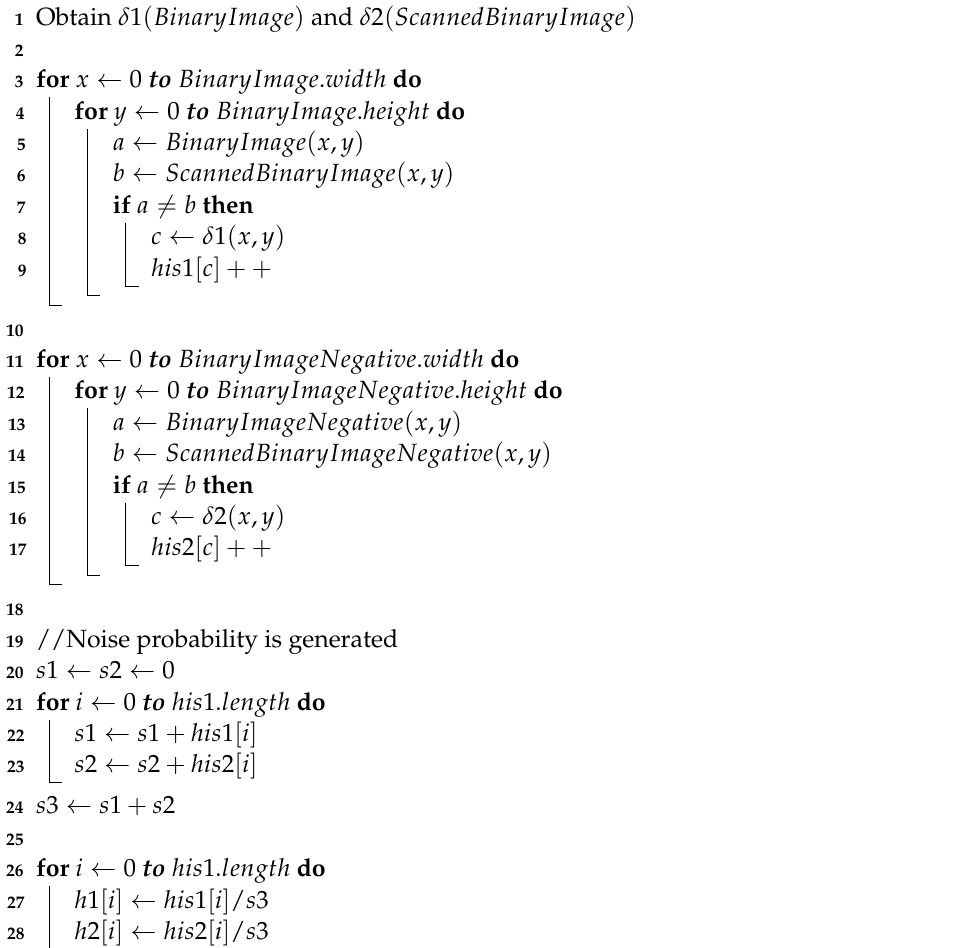
Algorithm 3 Noise probability distribution algorithm for binary